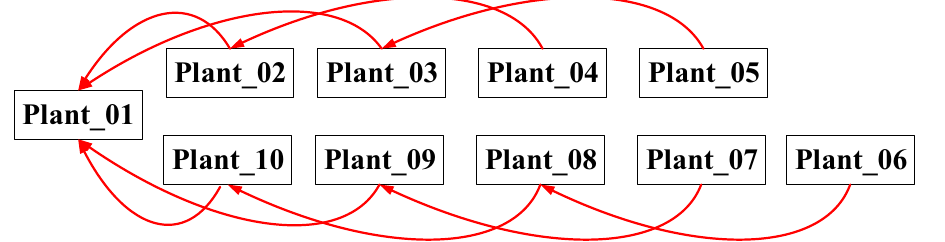
Figure 6. Schematic diagram of single-view point cloud registration target.